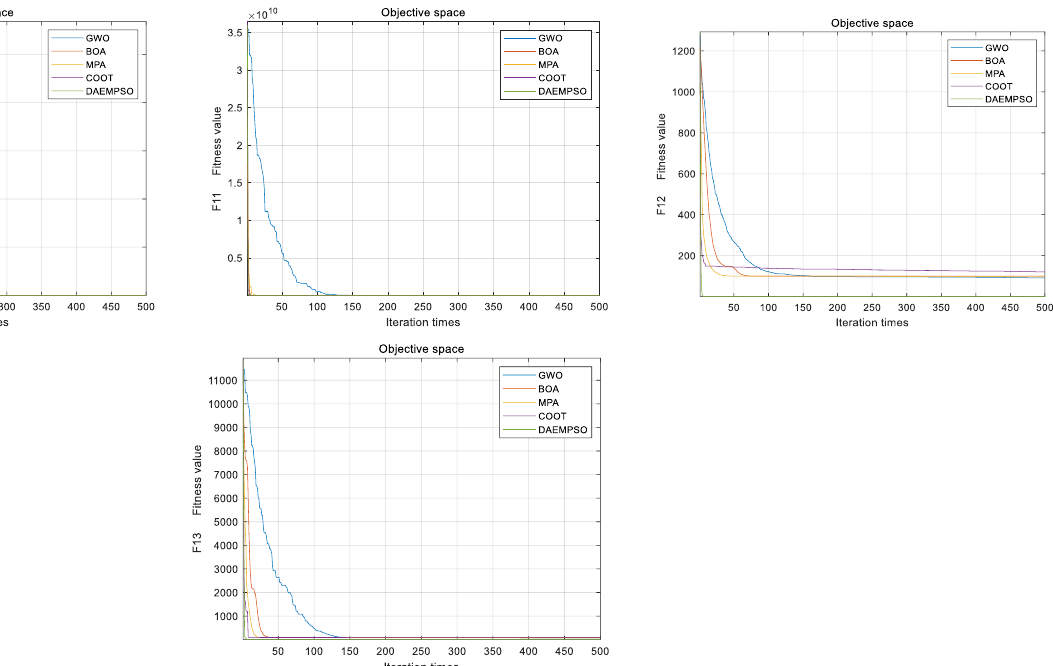
Figure 7. Convergence curves of five optimization algorithms for function (1000-dimension) F1 – F13 .